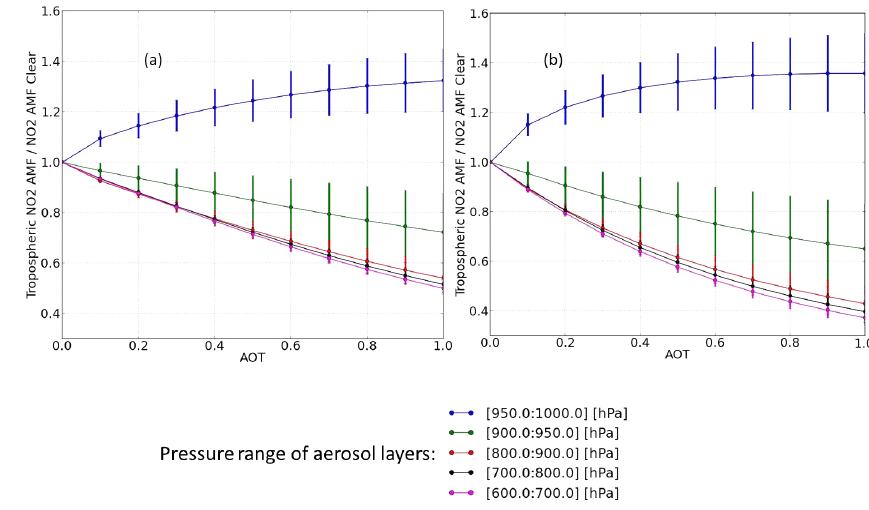
Figure 4. (a) Similar to Fig. 3a, but with NO 2 profiles for January. (b) Similar to Fig. 4a, but with SZA = 50 ◦ .